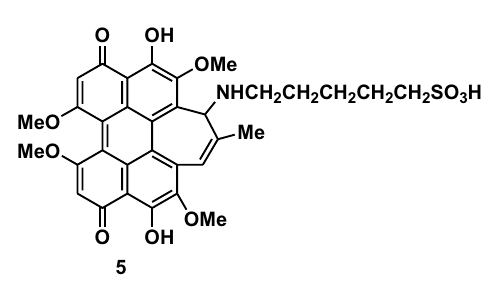
Fig. 6. The structure of 4 .